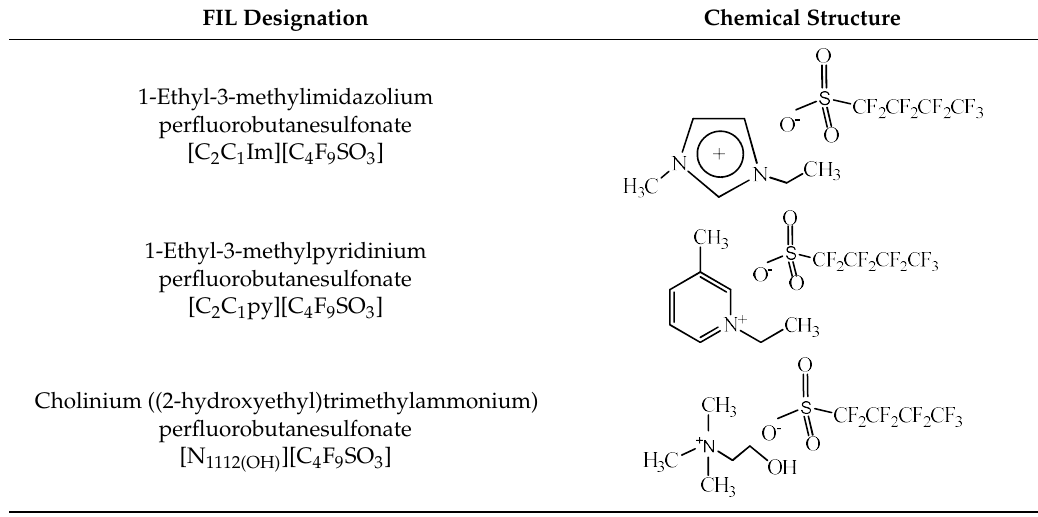
Table 1. Chemical structure and acronyms of the fluorinated ionic liquids (FILs) used in this work. FIL Designation